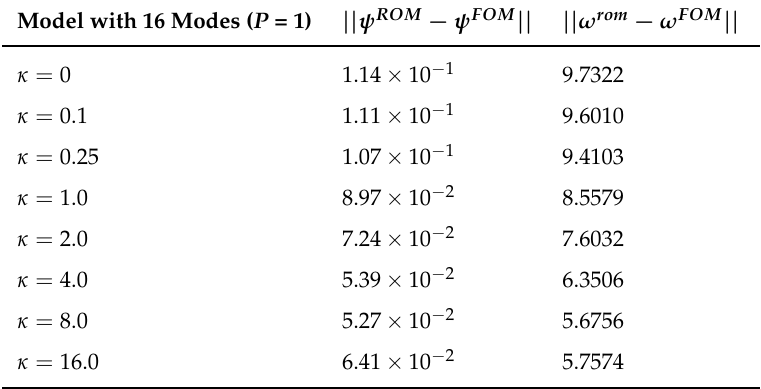
Table 2. Root-mean-squares error at time t = 4 between the standard Galerkin ROM ( P = 1, R = 16) and FOM in order to demonstrate the sensitivity with respect to the additional stabilization through κ at Re = 16,000.